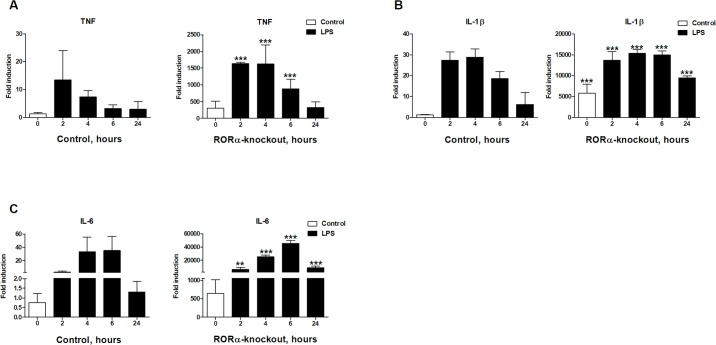
Cells lacking RORA have elevated inflammatory state.Deletion of RORA led to increase in basal and LPS-induced cytokine mRNA levels. A.
TNF transcript levels are elevated approximately 300 fold in differentiated knockout cells, B.
IL1B mRNA were nearly 5000 fold and C.
IL-6 almost 700 fold higher than in the control cell line. 2.5×105 cells in 24-well plates were differentiated using 50 ng/ml PMA for 48 hours. Stimulation was performed after 24 hours of rest in PMA-free media with 10 ng/ml LPS for 2, 4, 6 and 24 hours. Inflammatory cytokines expression levels were determined using qRT-PCR of RNAs isolated from cell lysates. Graphs are representatives for at least three independent experiments. Statistical significance was calculated using ANOVA test. Stars indicate significance of differences between control and knockout cells after post hoc Bonferroni correction.